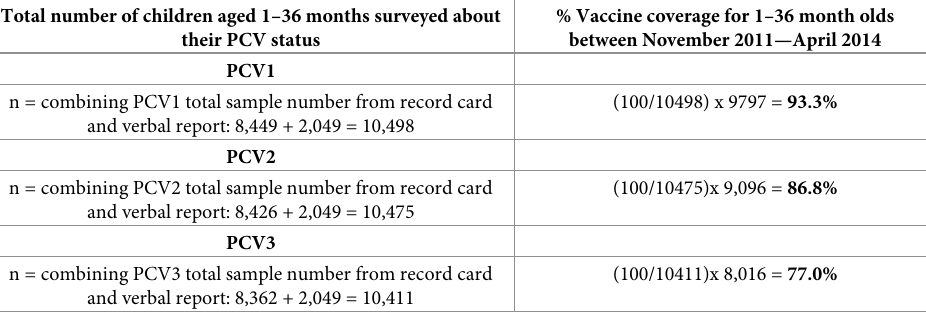
Table 3. PCV coverage calculations and result estimates.